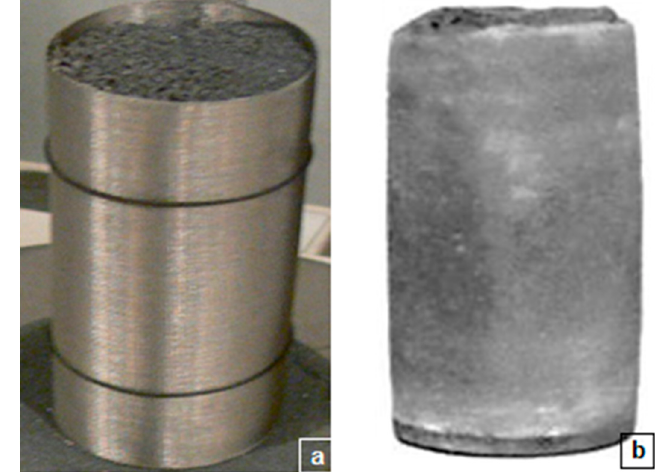
Figure 3. The appearance of the samples before and after combustion: ( a ) powder mixture before synthesis and ( b ) product after synthesis.